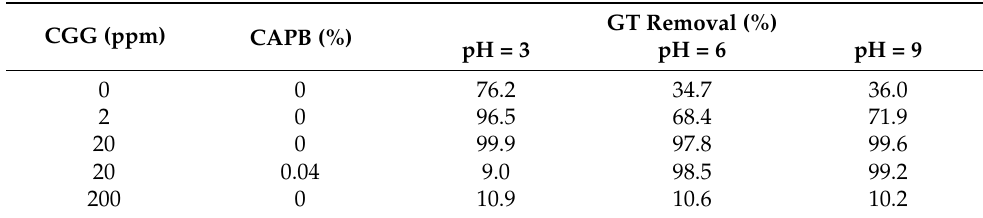
Figure 3. Influence of CGG with the addition of 0.04% CAPB on stability of the glauconite suspensions at pH = 9; 1 h ( a ), 15 h ( b ). Table 1. The influence of the pH and the CGG concentration on GT particle removal from the investigated system (IS 0.01) after 1 h.